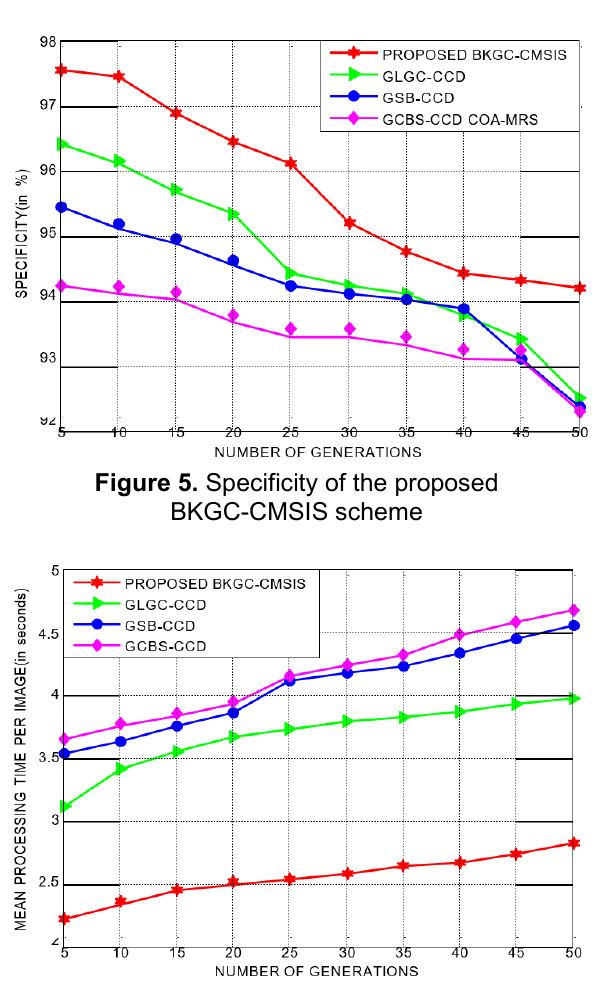
Figure 6. Average Processing time per image for the proposed BKGC-CMSIS